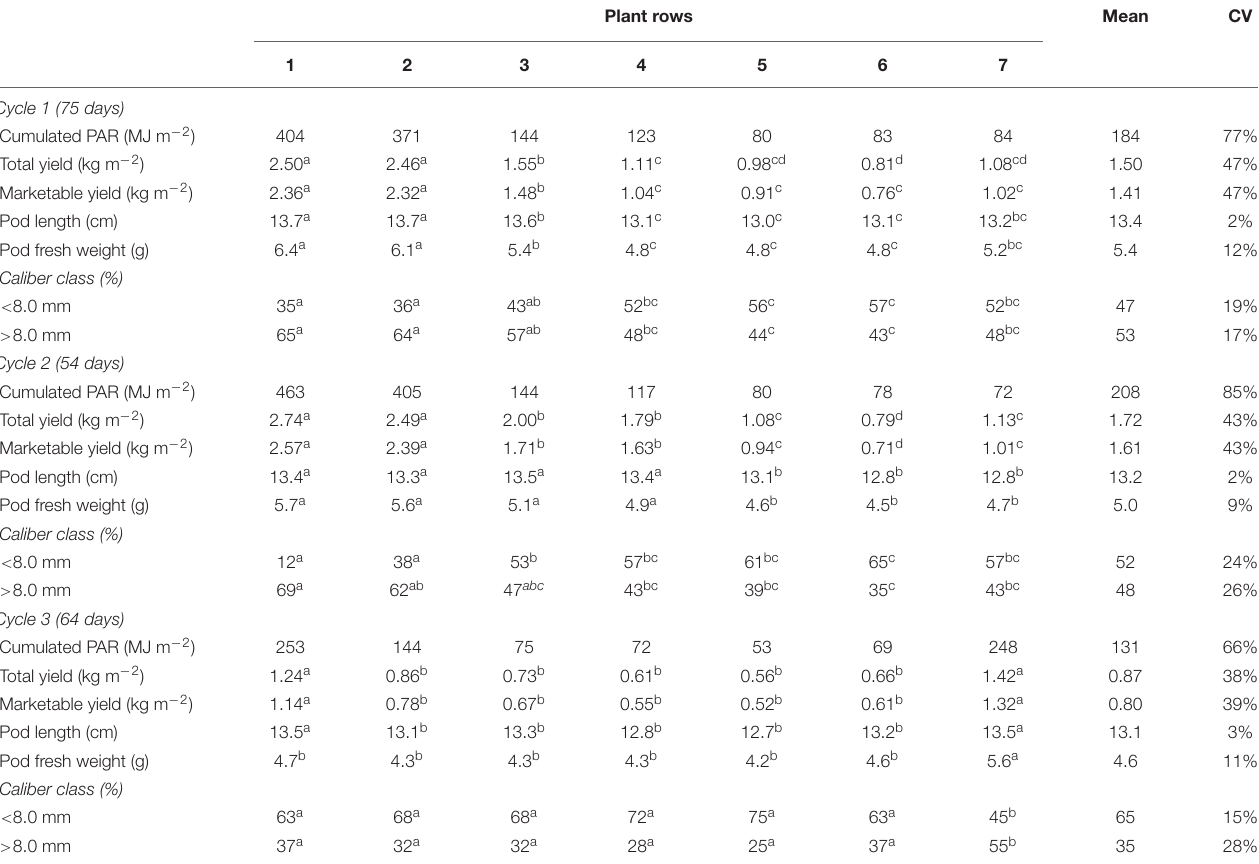
TABLE 1 | Average yield data per row after the three cycles.